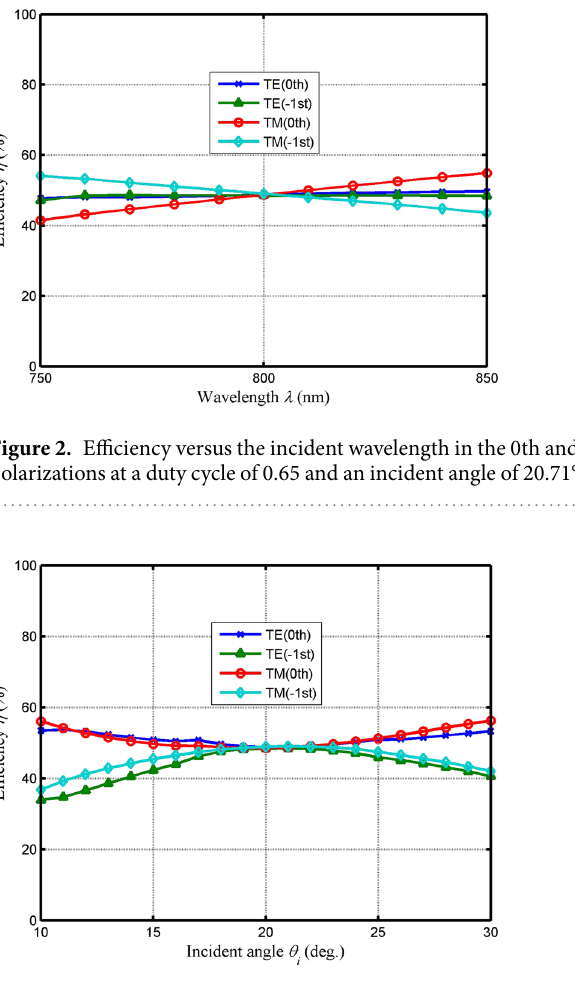
Figure 3. Efficiency versus the incident angle in the 0th order and the − 1st order for both polarizations at a wavelength of 800 nm under the Littrow mounting.